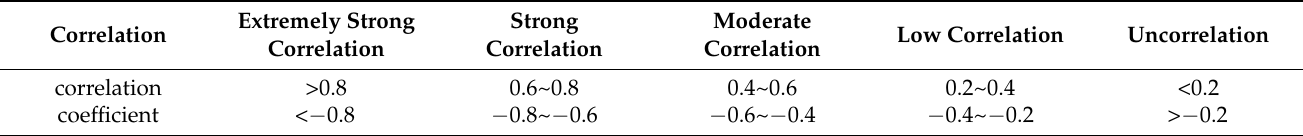
Figure 4. Correlation matrix among 35 feature variables in 2021. Table 3. Correlation levels of the correlation Table 4. The optimal feature variable sets for 2015 and 2021.